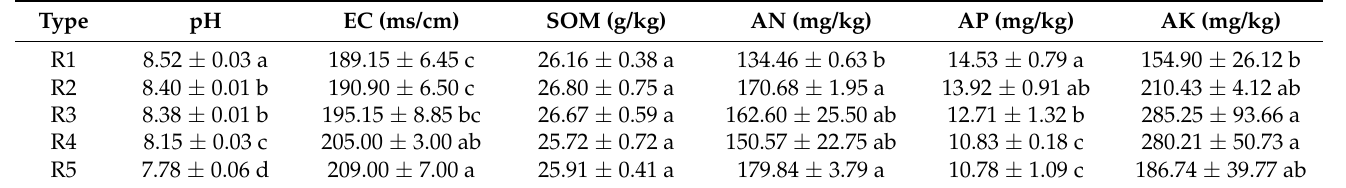
Table 1. Effect of different continuous cropping years on rhizosphere soil nutrient in industrial hemp.